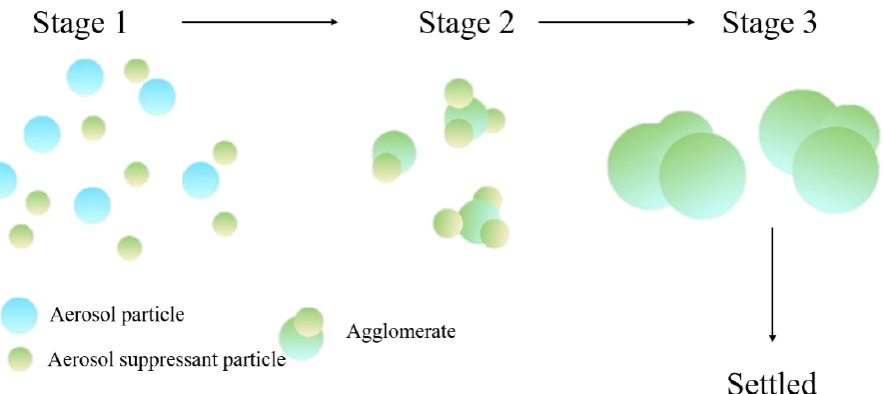
Figure 1. Schematic representation of coagulation and sedimentation of aerosol particles.